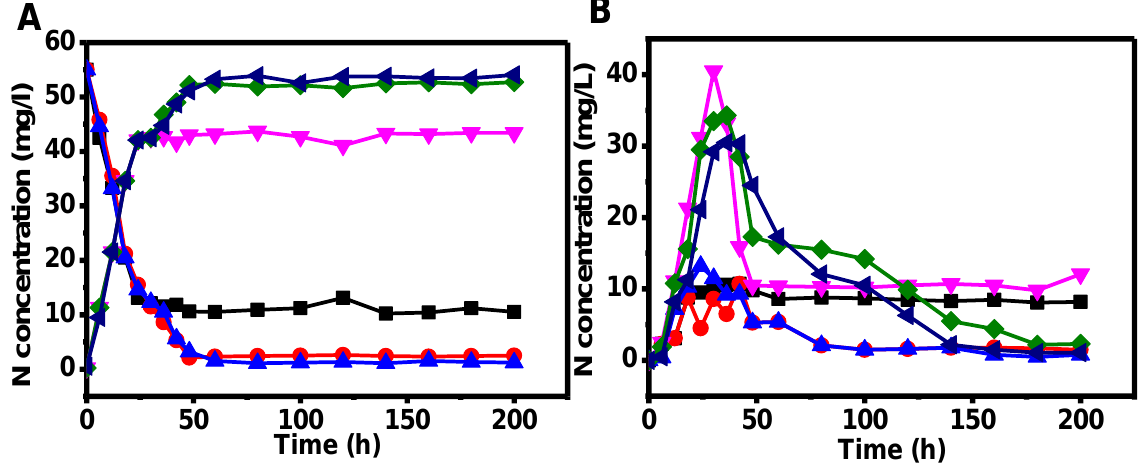
Figure 7. The nitrification and denitrification at anode and cathode, respectively, under continuous mode at different HRT with an applied voltage of 1.5 V. The ammonia-nitrogen removal and nitrate- nitrogen generation at the anode ( A ) and ammonia and nitrate-nitrogen profile at the cathode ( B ). The pink, green, and blue lines represent ammonia nitrogen at HRT of 15, 20, and 25, respectively, and the black, red, and light-blue lines represent nitrate-nitrogen at HRT of 15, 20, and 25, respectively.